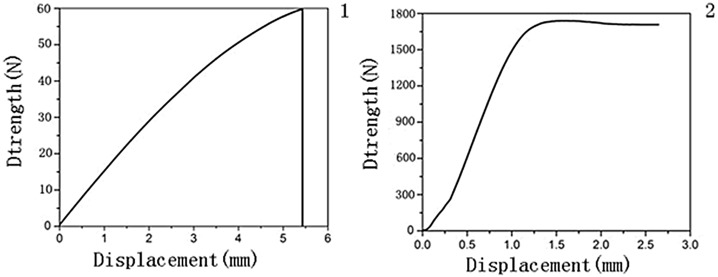
Representative stress strain curves.